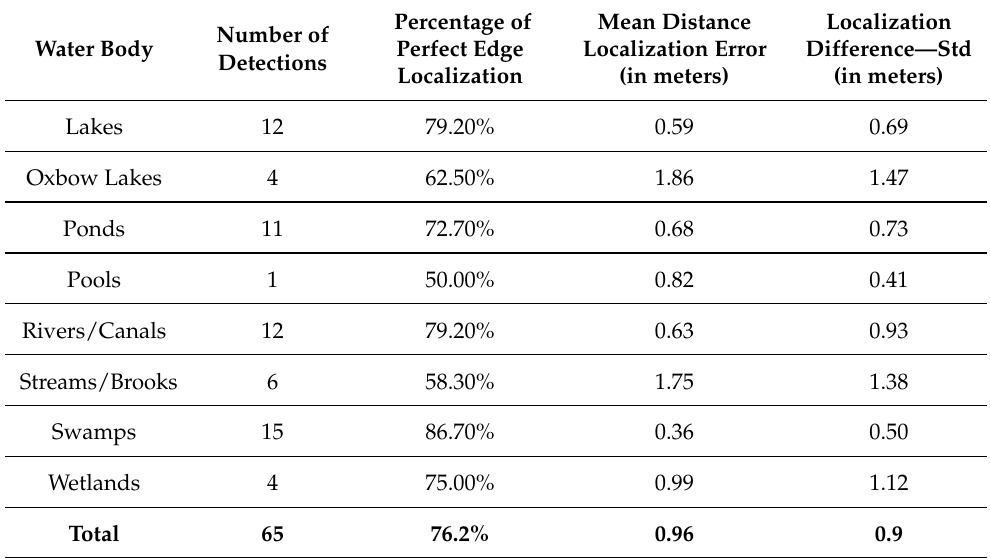
Table 4. Assessment of the accuracy of proposed radar technique for water body edge localization. Quantitative analysis of the difference between the automatic and manual edge localization for the detected water body surfaces by the traces of the 3 satellites footprints along the whole trajectory per water body type and in total (bold).